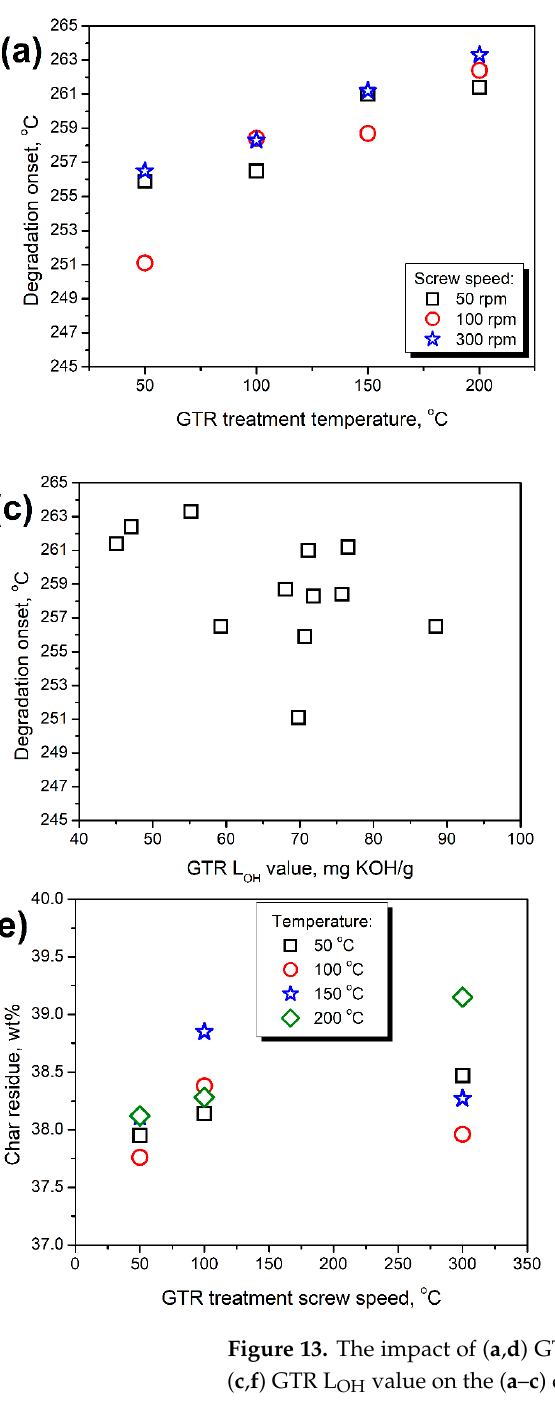
17 of 22 Figure 12. Mass loss curves obtained during thermogravimetric analysis of thermomechanically treated GTR samples and PU composite foams containing different GTR types: ( a ) 50/50, ( b ) 50/100, ( c ) 50/300, ( d ) 100/50, ( e ) 100/100, ( f ) 100/300, ( g ) 150/50, ( h ) 150/100, ( i ) 150/300, ( j ) 200/50, ( k ) 200/100, and ( l ) 200/300.